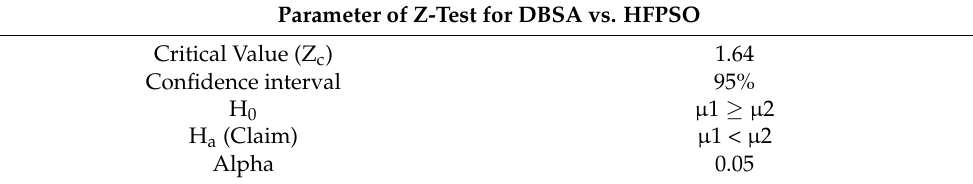
Table 13. Parameters used in Z-Test for DBSA vs. HFPSO.